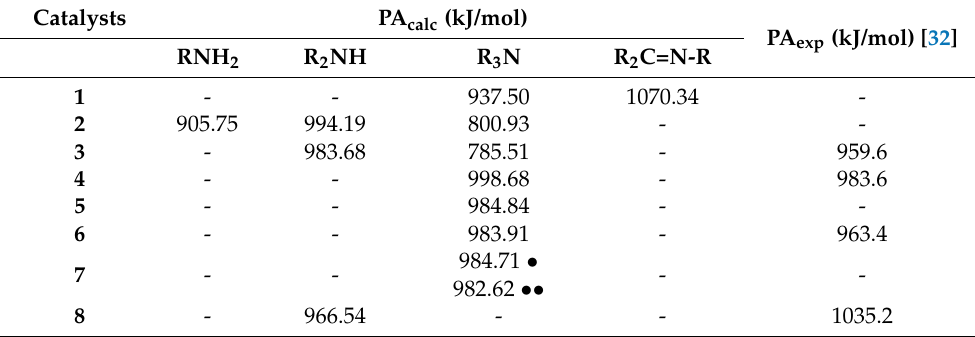
Table 3. Computed (PA calc ) and measured proton affinities (PAexp) in kJ/mol. The calculations have been carried out at the G3MP2BHandHLYP level of theory in gas phase at 298.15 K and 1 atm. RNH 2 ,